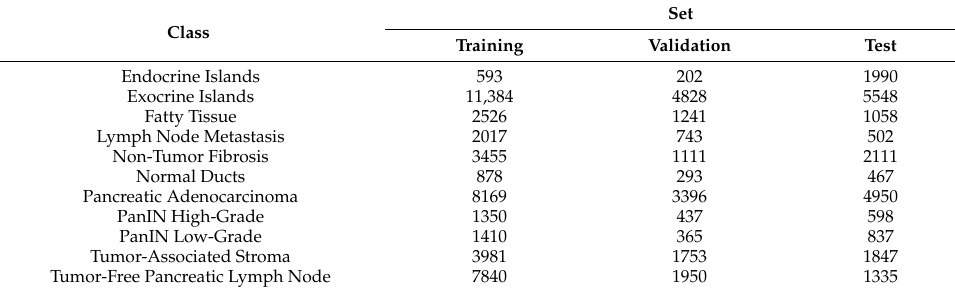
Table 2. Number of extracted image patches per